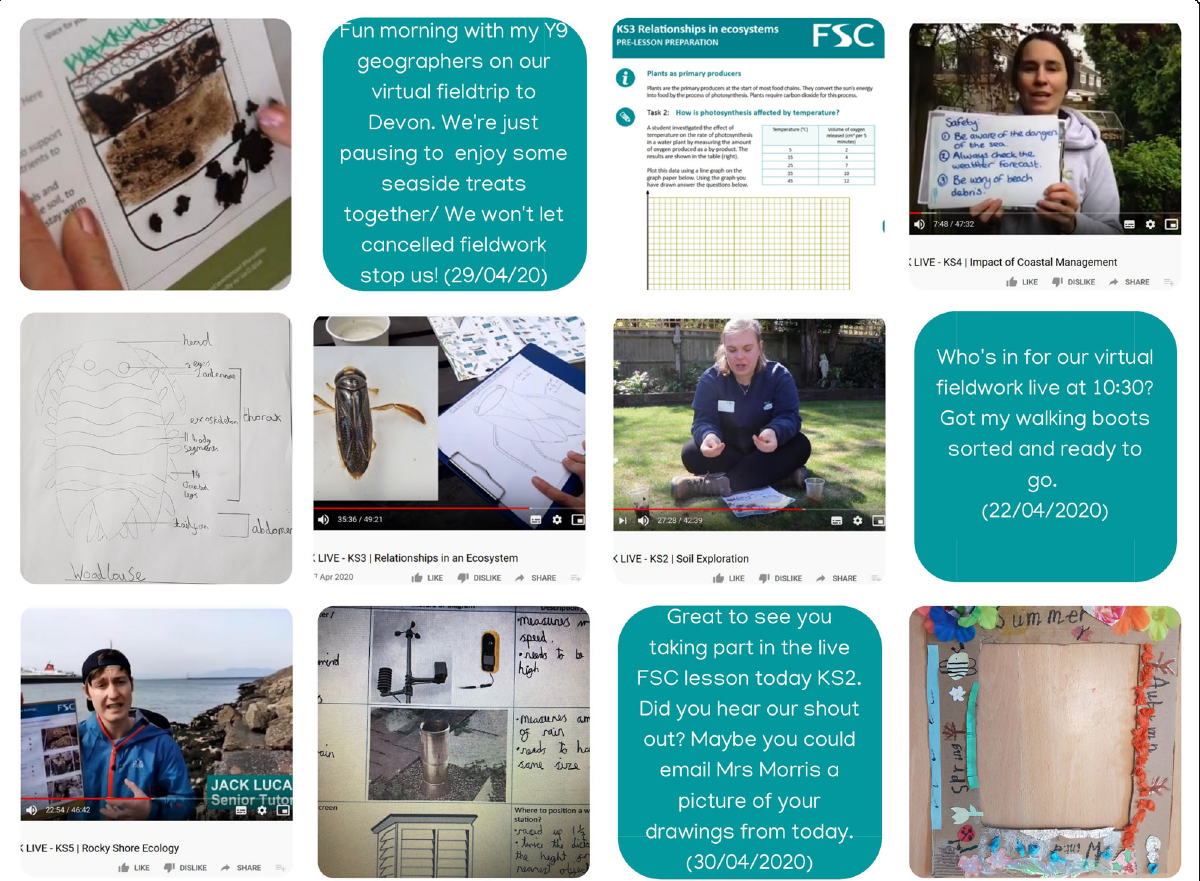
Fig. 3 Examples of video content, student work and Tweets shared via